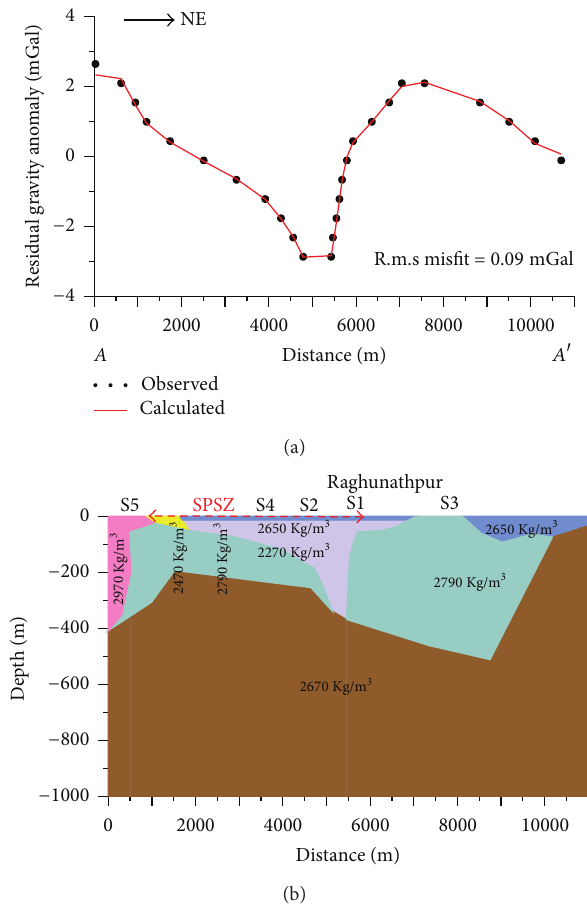
Figure 8: 2D model along AA 󸀠 without resistivity constraints with r.m.s misfit 0.12mGal. The red dashed line in the model section indicating the width of the South Purulia Shear Zone (SPSZ).